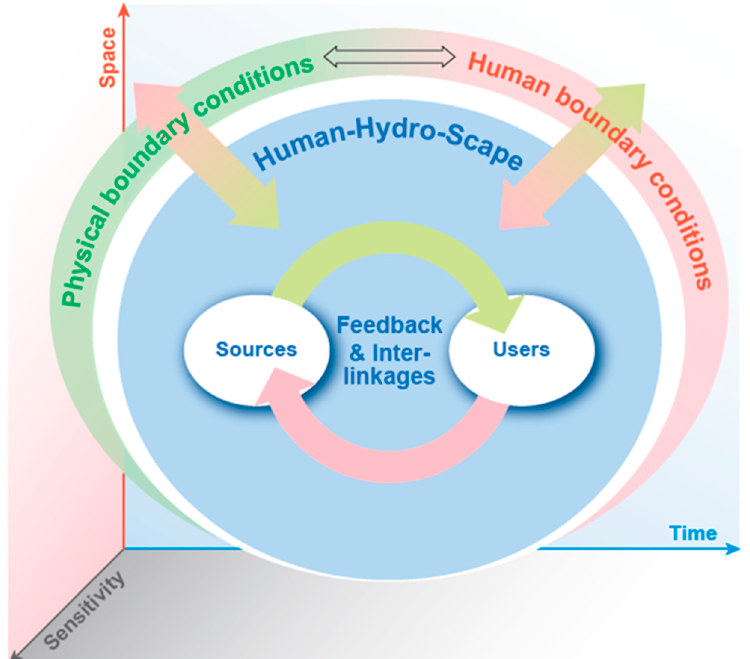
Figure 1. Conceptual model of the Pluralistic Water Research (PWR) concept. Within this framework, sources of water are, for example, rivers, reservoirs or groundwater, while users are humans and their demands. The sources and users are shaped by reciprocal physical and human boundary conditions, in a setting called human-hydro-scape. Space, time and sensitivity are regarded as key factors in human-water interactions and processes of feedback and interlinkages. Figure developed by the authors.